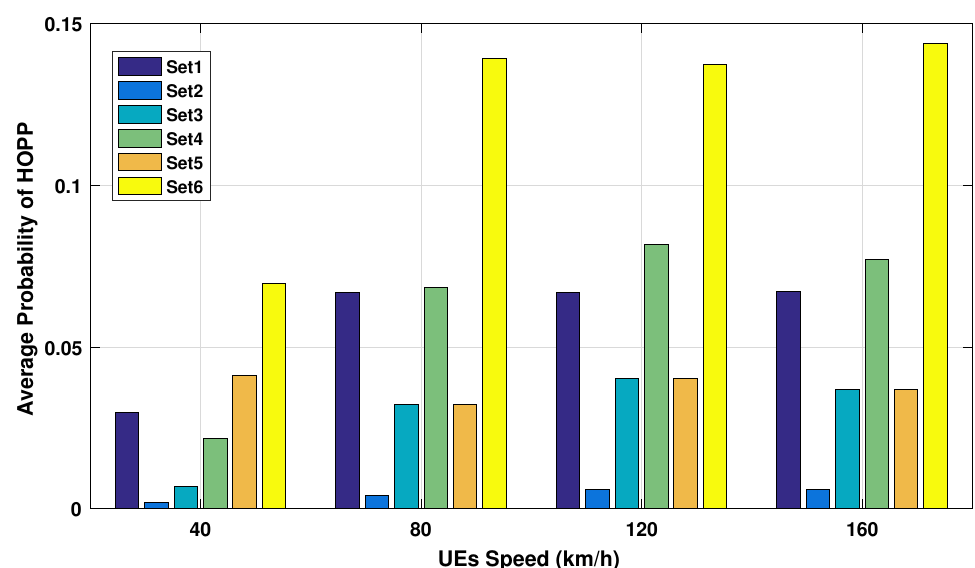
Figure 5. Average probability of HOPP vs. UE